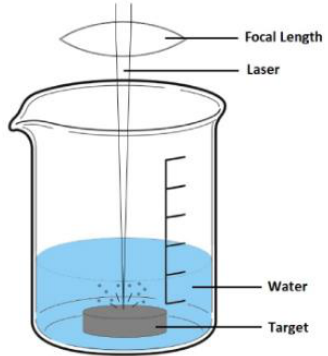
Figure 1. Experimental setup used for nanoparticles’ synthesis by Pulsed Laser Ablation in liquid technique: laser pulse irradiation onto gold target immersed in water causes the gold outer surface atoms to vaporize and condense in the water, forming the nanoparticles.